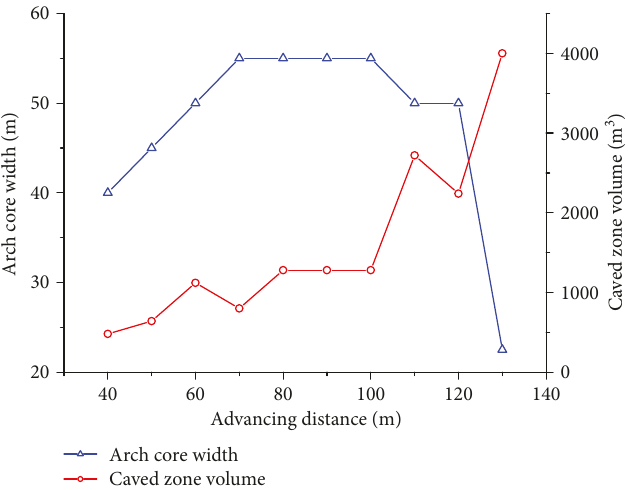
Figure 11: The width of the pressure arch core and failure volume of the strata caused by coal